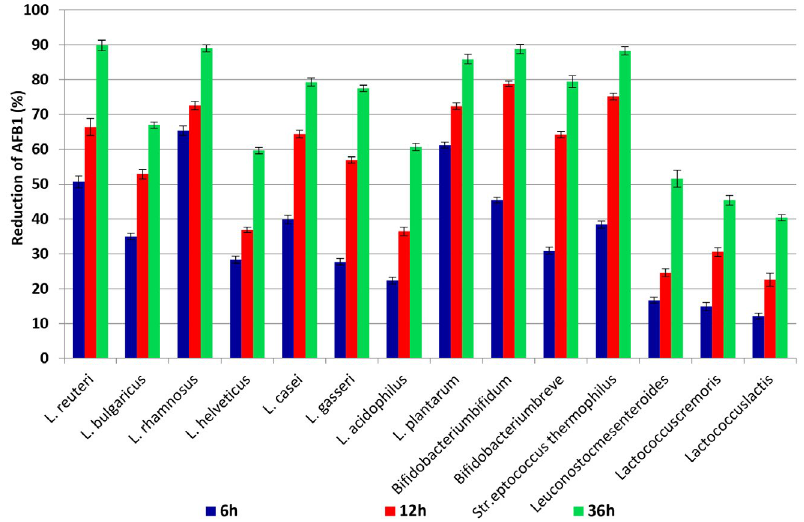
Fig. 2. The percentages of reduction AFB1 after incubation for 6h, 12h and 36h at 37°C with LAB Table 2. ANOVA of the effect of different incubation time and type of LAB strains on reductionAFB1 Source SS df